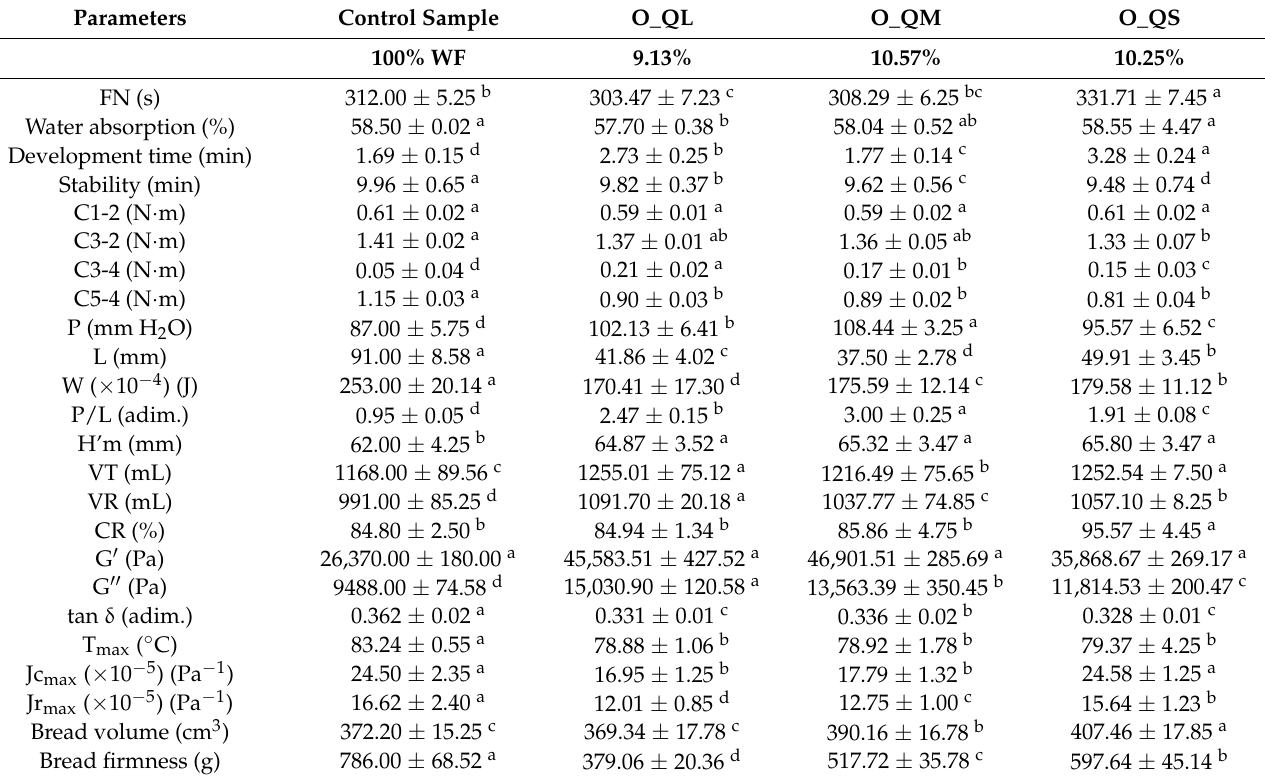
Table 4. Wheat flour dough and optimized composite flour for each quinoa flour particle